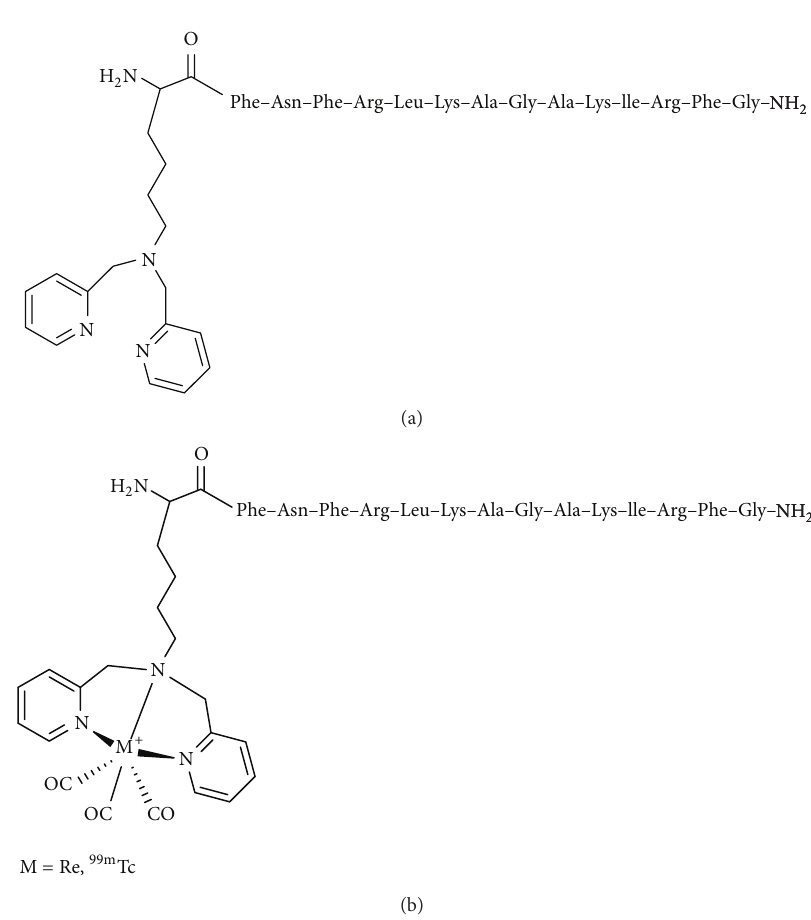
Figure 2: Structures of (a) SAAC-PSBP-6 and (b) SAAC(Re)-PSBP-6 and SAAC( 99 m